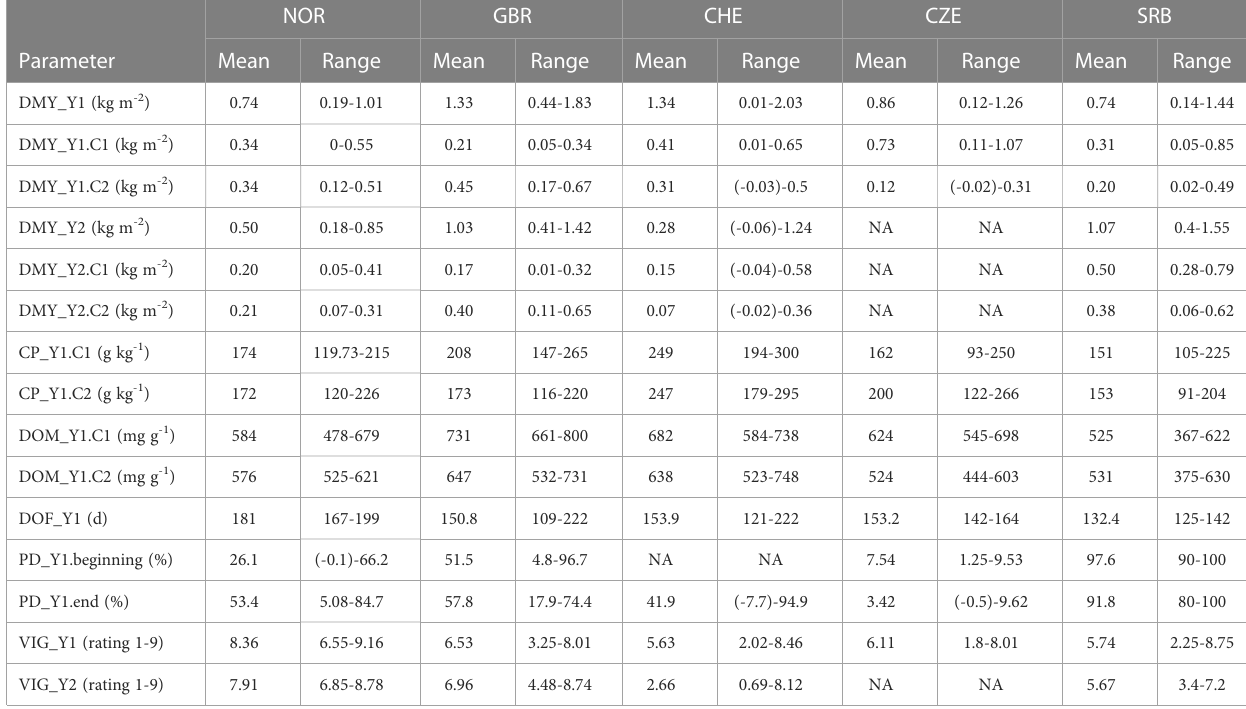
TABLE 3 Mean and range of best linear unbiased estimators (BLUE) per accession observed at the fi ve different locations.